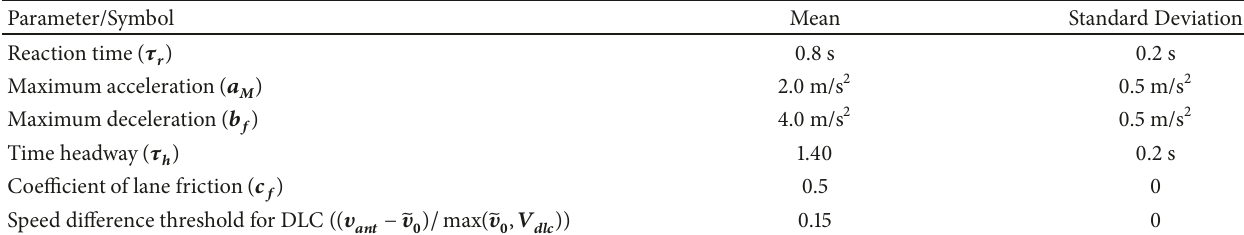
Table 1: Calibrated PATH model parameters of the SR99